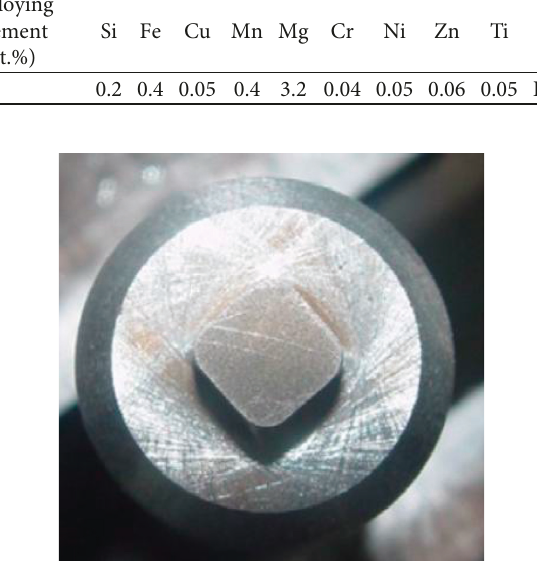
Figure 1: End view of the tool showing its shoulder and the square pin